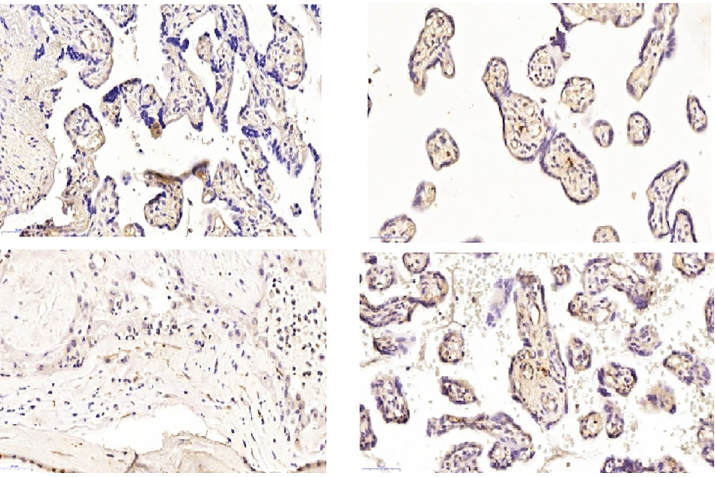
Fig 3. Representative evaluation of placental, hematoxylin–eosin findings. (A) granuloma (40 × objective) (B) leukocyte infiltrate (40 × objective); (C) acute chorioamninonitis (40 × objective); (D) Hofbauer cells (40 × objective).